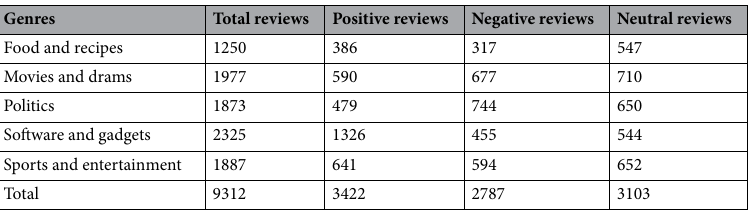
Table 4. Statistics of proposed